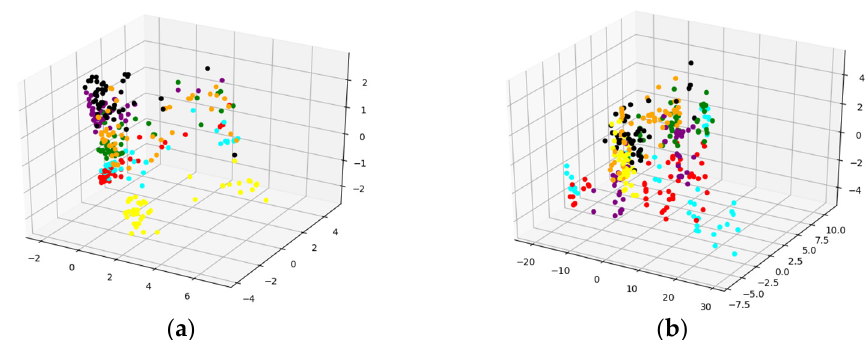
Figure 14. PCA visualization results: ( a ) Hilbert–Huang transform and ( b ) wavelet transform.